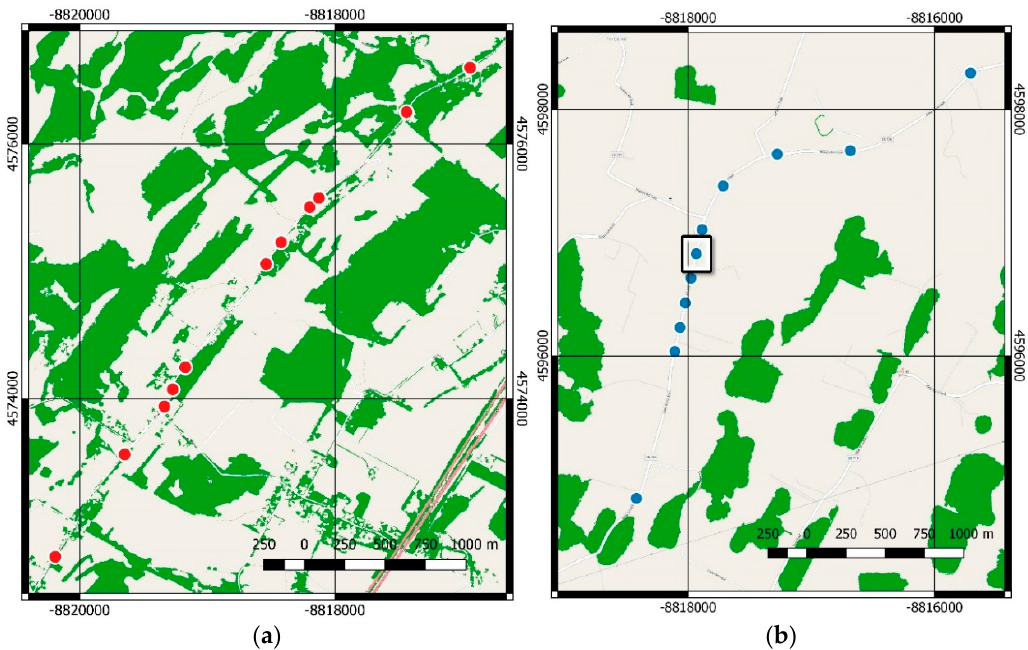
Figure 9. ( a ) Examples of locations affected by type-II errors (red markers) and their relationship to nearby tree stands (green-shaded regions). Most type-II errors are found in the direct vicinity of tree stands; ( b ) distribution of type-I errors along Glebe School Road, Augusta County, VA. The presence of type-I errors (bad road segments misclassified as good road segments) in a series of consecutive 0.1-mile road segments suggests road maintenance between the collection of the IRI and SAR data samples. The area marked by a black rectangle is further analyzed in Figure 10.